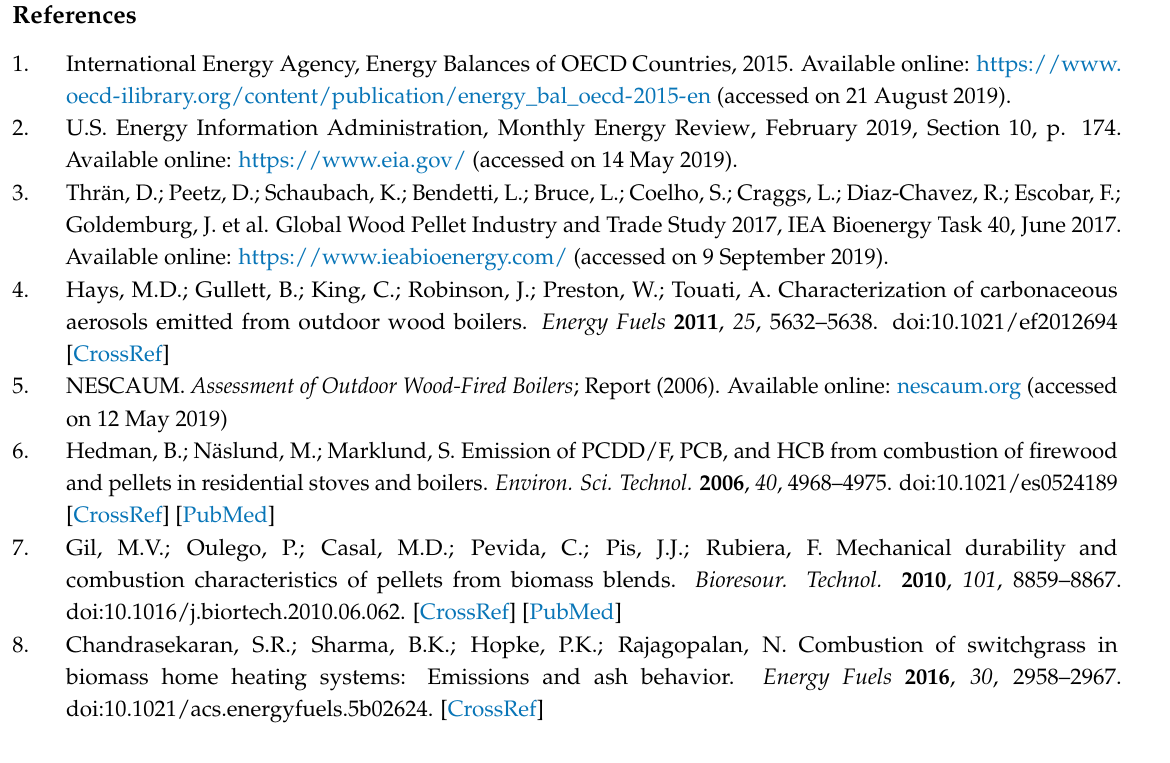
Individual SVOC concentrations, Figure S3: PM emission factors, Figure S4: OC-EC data, Figure S5: PAH literature comparisons, Table S1: Fuel analysis results, Table S2: Descriptive statistics for individual SVOC concentrations in PM. A description of emission factor calculations are also